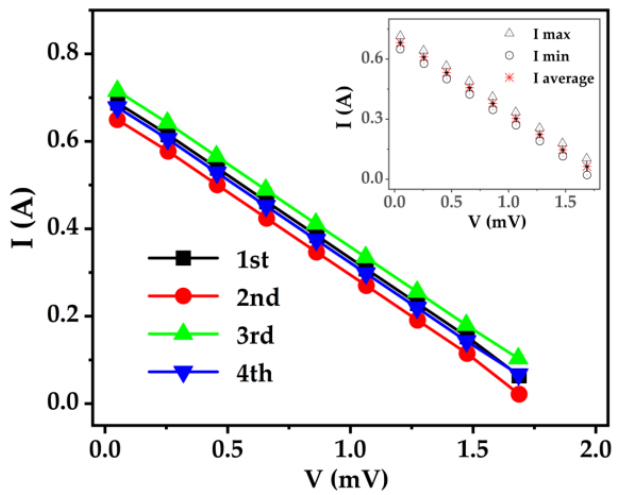
Figure 7. V–I curve of Fe/BTS ATMTTD at a fixed Δ T of 20 K after being testing four times. The inset shows the differences with the self-made measuring equipment.